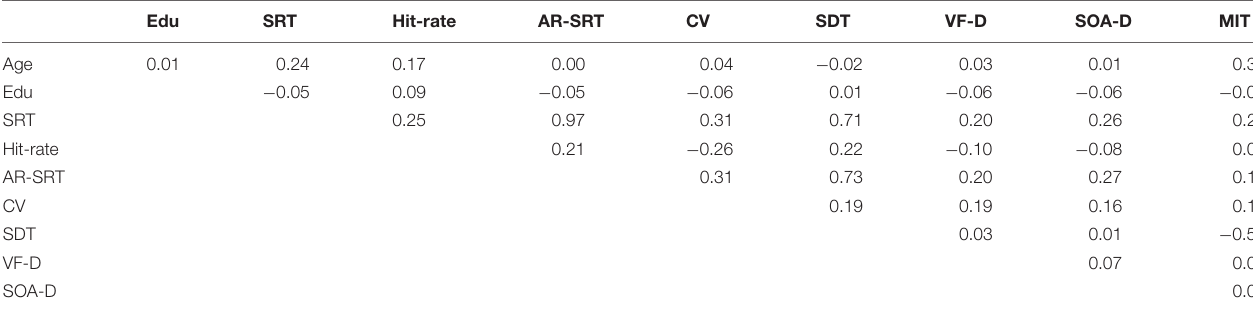
TABLE 3 | Correlation matrix for Experiment 1.